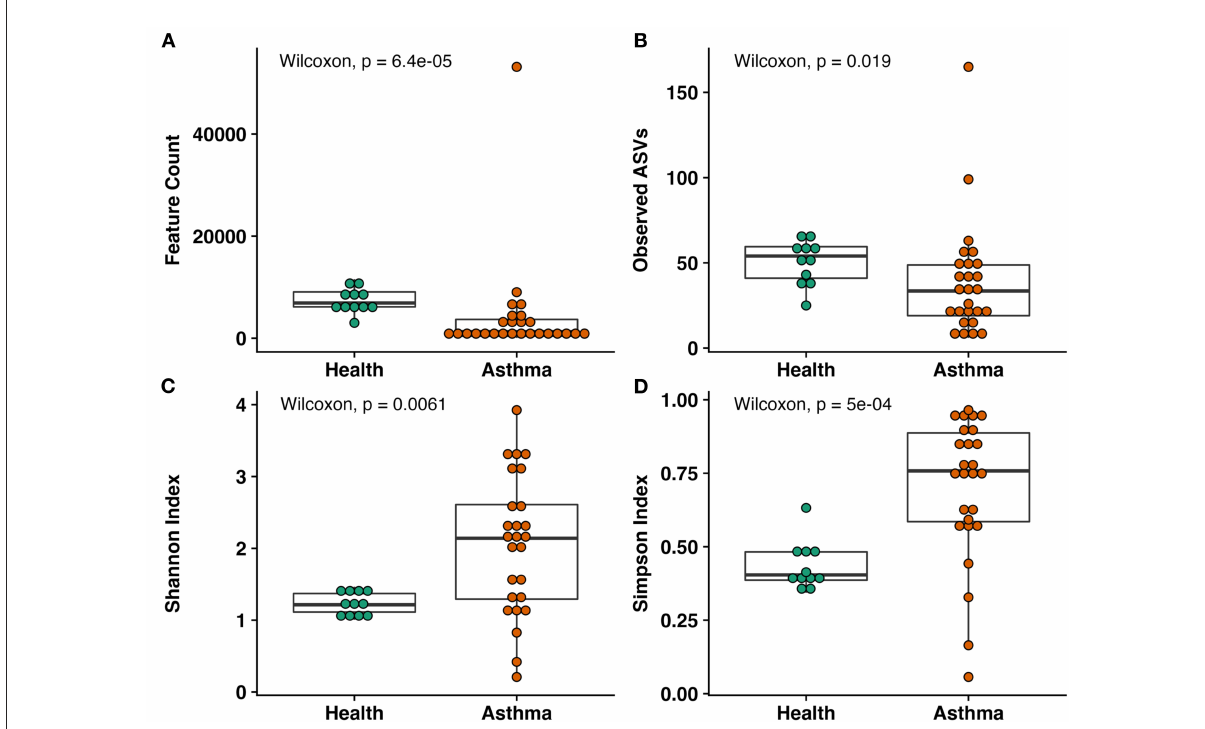
FIGURE1 Alpha diversity metrics including (A) total observed features, (B) within sample richness, (C) Shannon Index, and (D) Simpson Index. Significant decreases in coverage and richness were observed in asthma compared to healthy cats. Within sample diversity was significantly increased in asthmatic cats compared to healthy cats. Wilcoxon rank sum test, p -values indicated.